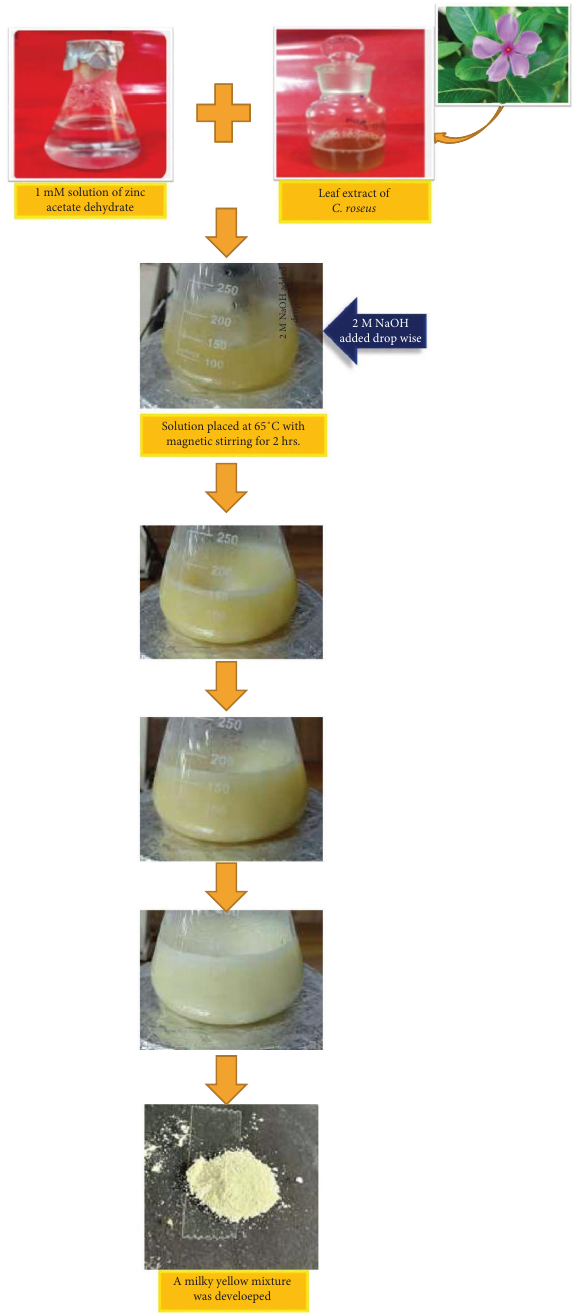
Figure 1: Schematic representation for the formation of ZnO